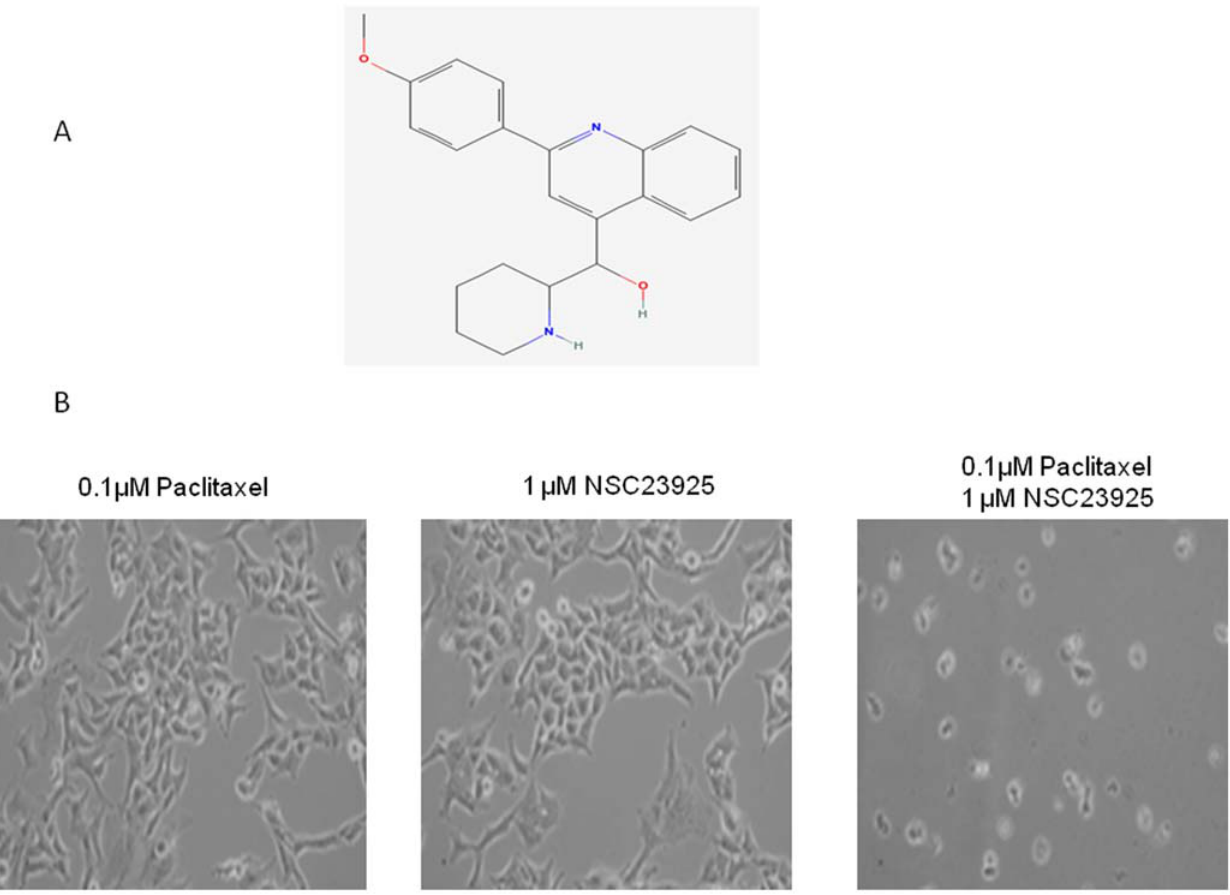
Figure 2. Chemical structure of NSC23925 and reverse paclitaxel resistance by NSC23925. A : Structure of NSC23925. B : NSC23925 in combination with 0.1 m M paclitaxel induces significantly cell death in SKOV-3 TR .